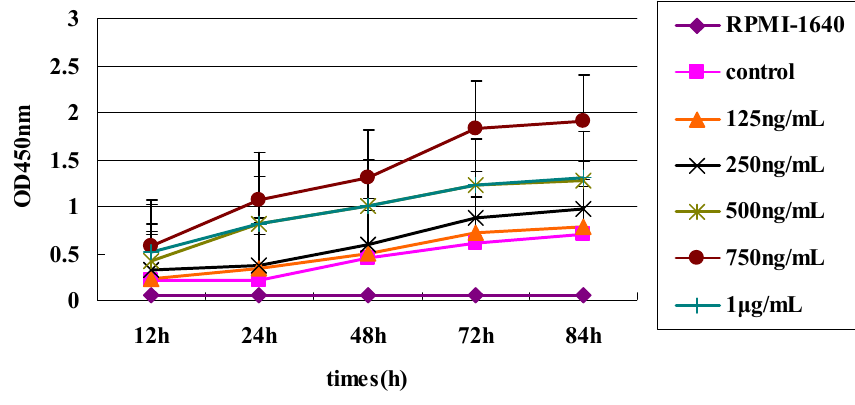
Figure 4. Cell growth curves of the Raji cell line. Raji cells were grown in 96-well plates at 37 °C in Roswell Park Memorial Institute (RPMI)-1640 (GibcoBRL, Gaithersburg, MD, USA) with calf serum and five different concentrations of BAFF (125 ng/mL to 1 μ g/mL). Measurements were taken at 12, 24, 48, 72 and 84 h. The negative control used only RPMI-1640 without BAFF. The number of Raji cells detected by CCK-8 assay was highest when incubated with BAFF (750 ng/mL) for 72